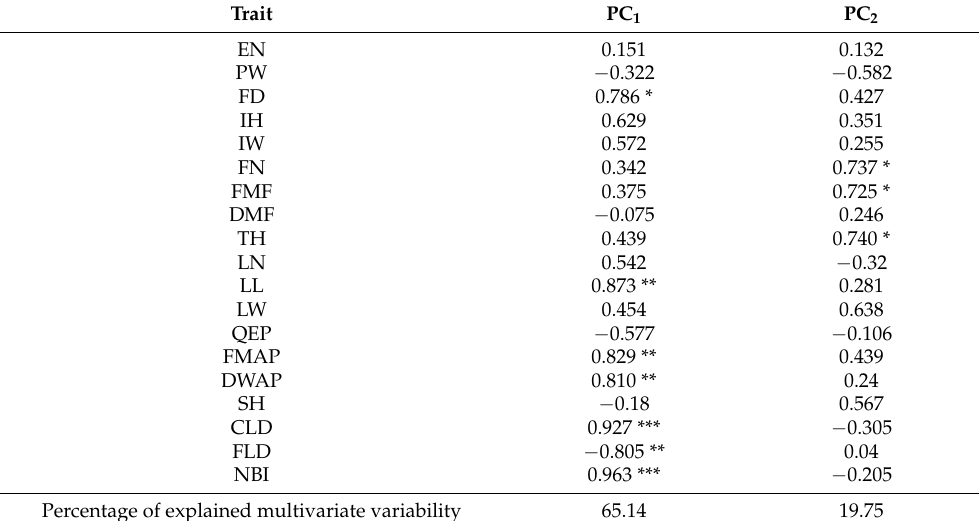
Figure 3. Distribution of combinations in space of the first two canonical variables. 1—control; 2—Bisterane (hydrogen peroxide stabilized with silver—H 2 O 2 -Ag + ) 1%; 3—Bisterane (Silver stabilized hydrogen peroxide—H 2 O 2 -Ag + ) 2%; 4—Bisterane (hydrogen peroxide stabilized with silver—H 2 O 2 -Ag + ) 3%; 5—Bisterane (hydrogen peroxide stabilized with silver—H 2 O 2 -Ag + ) 5%; 6—Bisterane (hydrogen peroxide stabilized with silver—H 2 O 2 -Ag + ) 10%; 7—Yamato 303 SE 0.5%; 8—Signum 33 WG 0.5%; 9—Biszop 80 WG 1%. Table 7. Correlation coefficients between the first two canonical variates and studied traits.